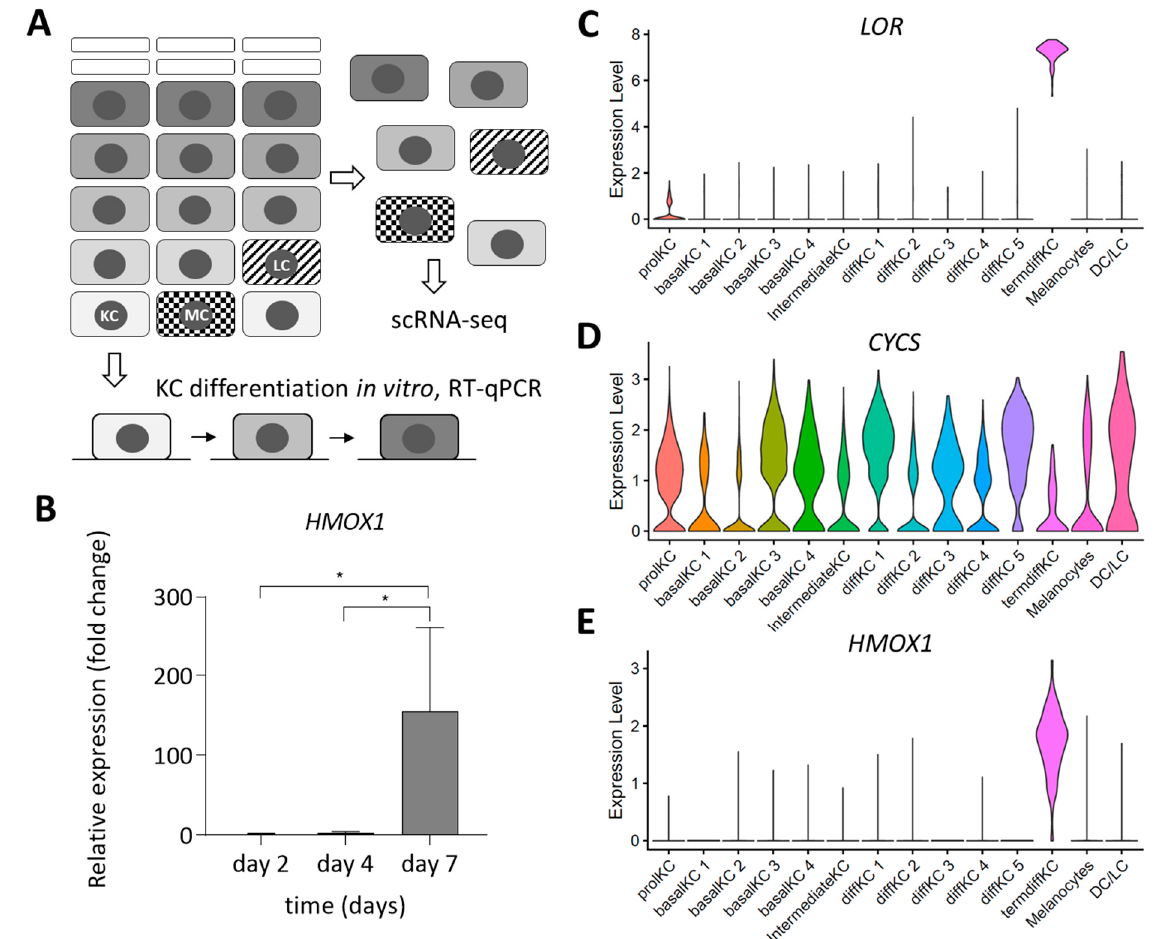
Figure 2. Heme oxygenase-1 ( HMOX1 ) mRNA is upregulated during terminal differentiation of human epidermal keratinocytes. ( A ) Schematic depiction of experiments aimed at the determination of gene expression in differentiating keratinocytes. The epidermis consists largely of keratinocytes (KC) but also contains melanocytes (MC) and Langerhans cells (LC). KCs were isolated and induced to undergo differentiation in vitro by maintenance in confluent culture for up to 7 days, followed by reverse transcription-quantitative PCR (RT-qPCR) analysis. In separate experiments, cells were isolated and subjected to single-cell RNA sequencing (scRNA-seq). ( B ) RT-qPCR of HMOX1 in human KCs differentiating in vitro. Relative expression levels are normalized to a reference gene. Asterisks indicate significant differences ( p < 0.05), as determined by one way ANOVA. ( C – E ) Single-cell transcriptomic analysis of Loricrin ( LOR ) ( C ), Cytochrome c ( CYSC ) ( D ) and HMOX1 ( E ) expression in cells of the human epidermis. A published dataset was analyzed, using the same designation of cell populations [30]. The violin plots show the log-transformed single-cell expression level on the vertical axis and the frequency of cells at different expression levels in the horizontal dimension. DC, dendritic cells; diffKC, differentiating KC; LC, Langerhans cells; prolKC, proliferating keratinocytes; termdiffKC, terminally differentiated keratinocytes. HMOX1 was expressed only at minimal levels in the initial phase of keratinocyte differentiation in vitro and increased more than 100-fold on day 7 of the confluent culture